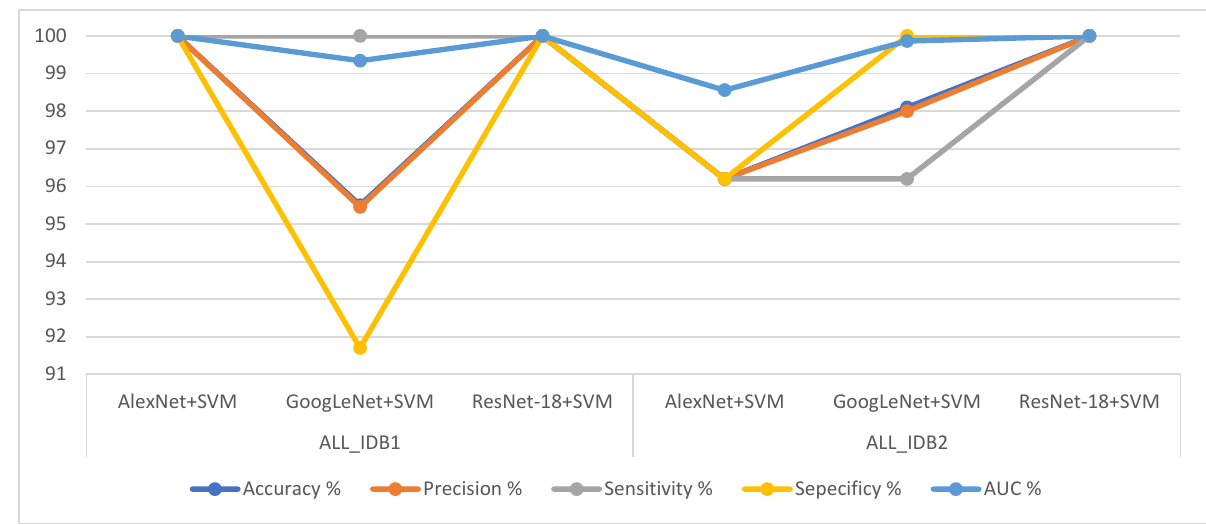
Figure 25. Performances of all the hybrid techniques for the ALL_IDB1 and ALL_IDB2 datasets.